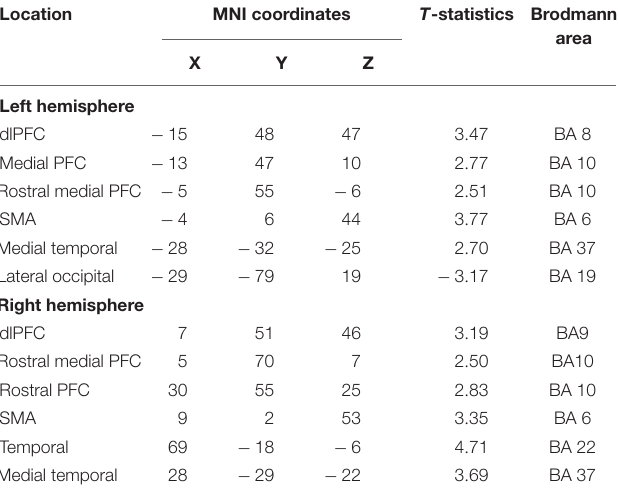
TABLE 2 | Maxima of regions showing significant differences between the Updating and control locations in the source space during the component N1P2 of the RotEP.